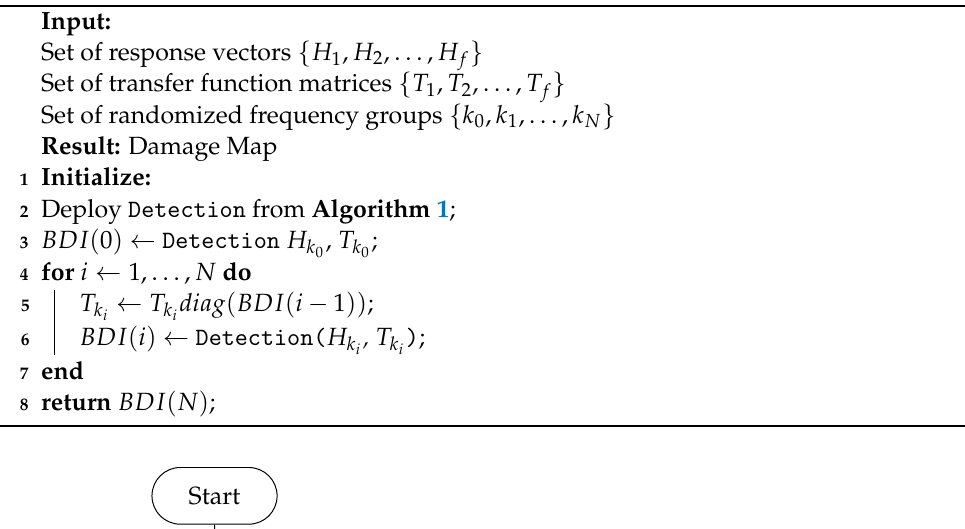
Algorithm 2: Adaptive Complex Group Lasso For Damage Detection